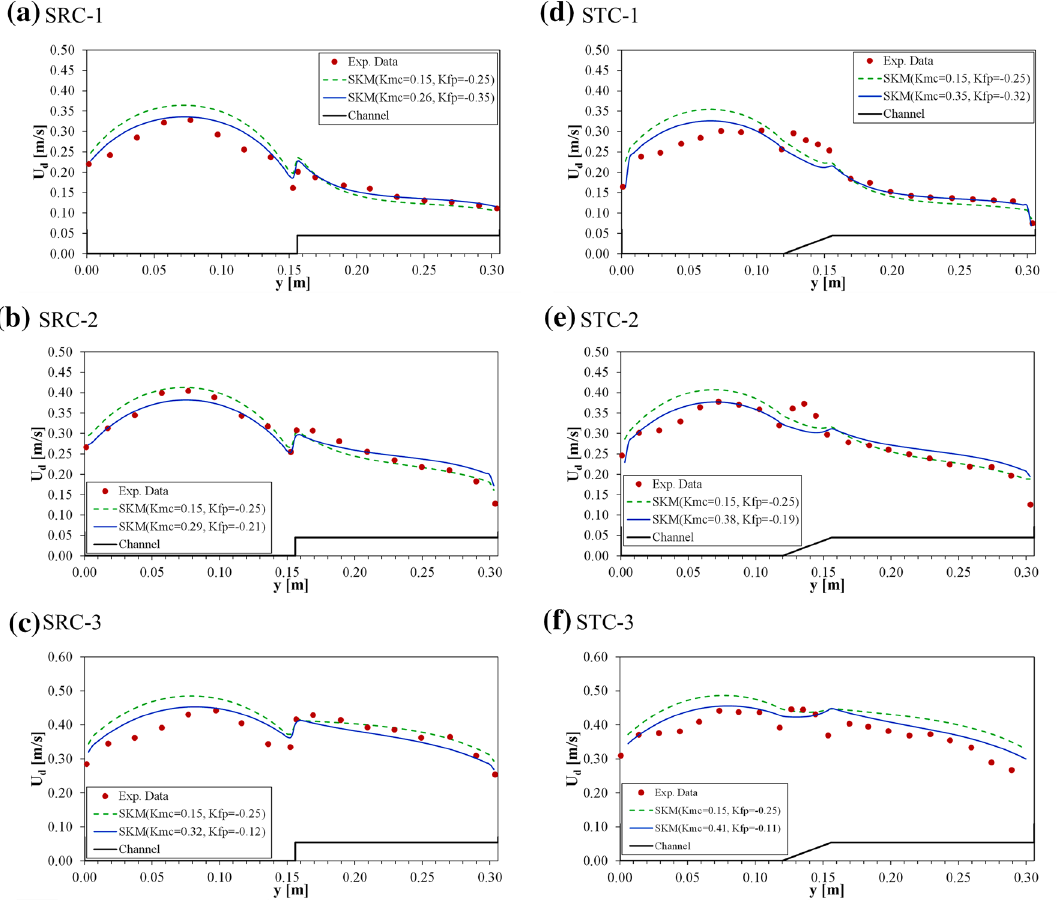
Fig. 4 Results of boundary shear stresses for small-scale compound channels (the solid line: k calibrated by Devi and Khatua approach, the dashed line: k assumed as Abril and Knight